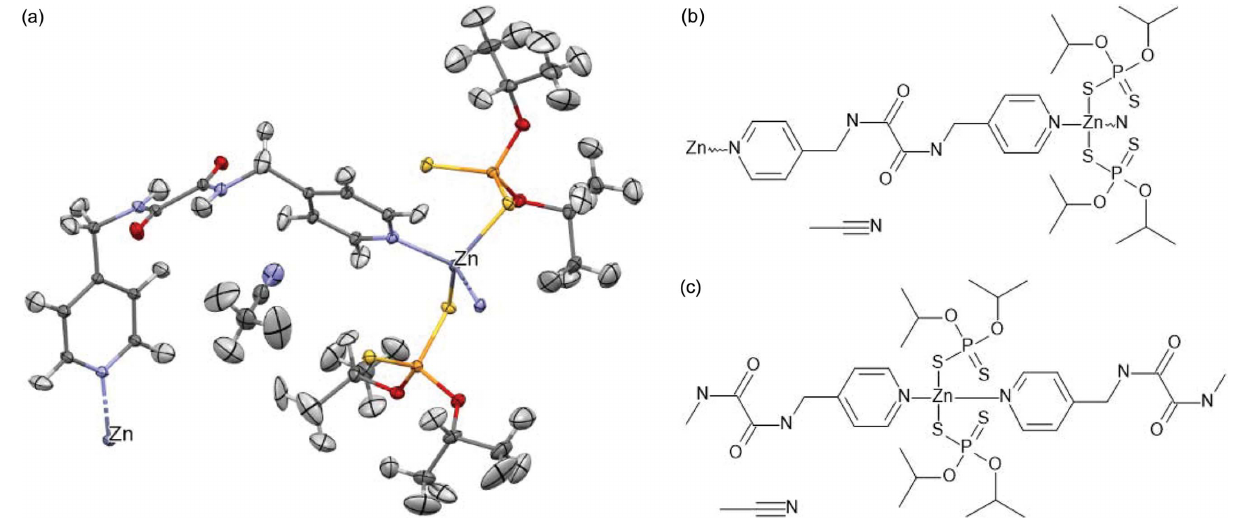
Figure 14 Polymeric system (XUGSEA): ( a ) structure from HAR, ( b ) structural formula, ( c ) fragments used in